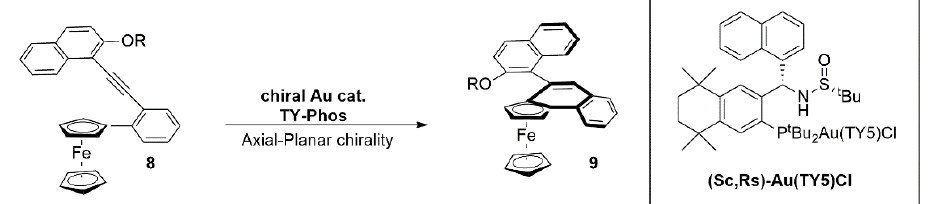
Figure 5. Gold-catalyzed asymmetric intramolecular hydroarylation of available ortho-alkynyl-ferrocene derivatives ( 8 ) together with the structure of the best selected catalyst.